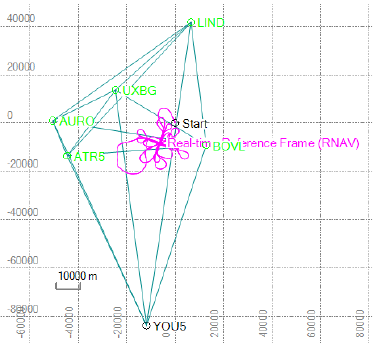
Figure 3: Airborne Survey Trajectory and ASB™ Network